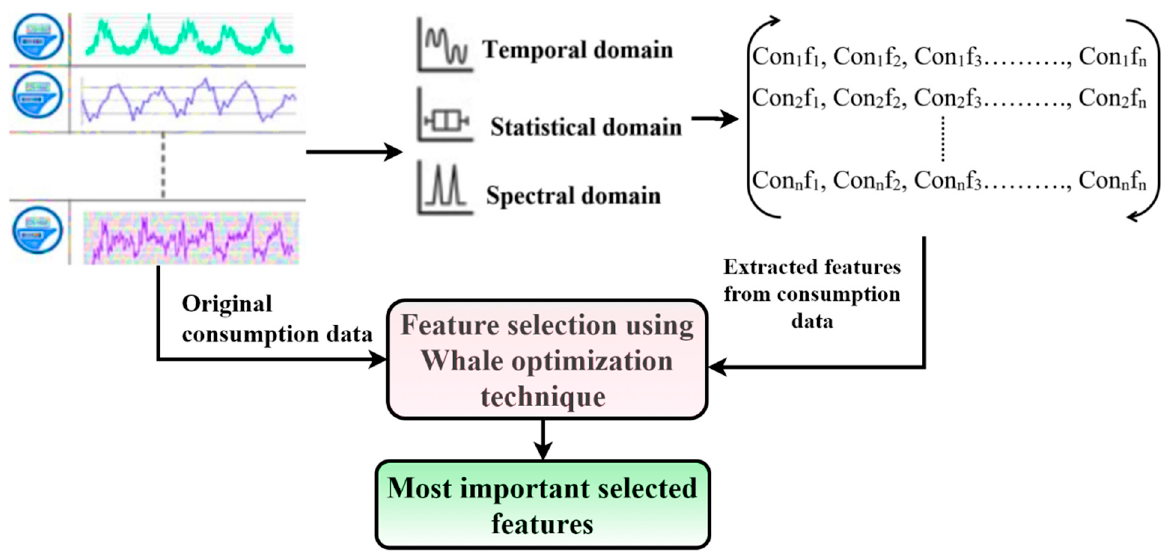
Figure 10. Feature selection using the WOA-FS